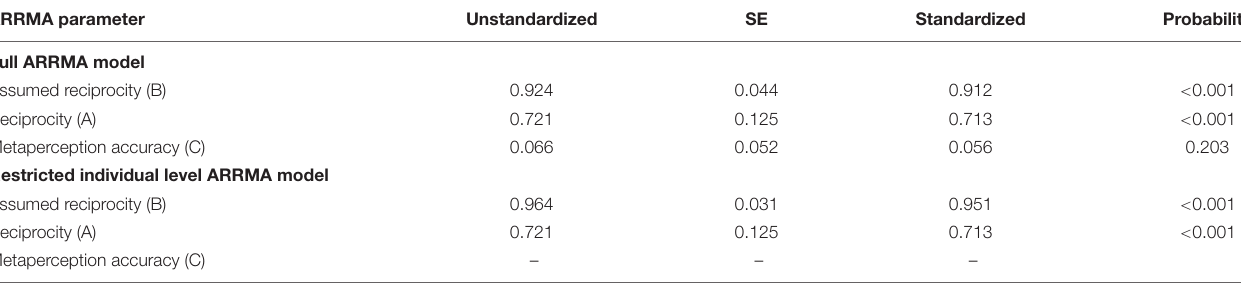
TABLE 2 | Individual level ARRMA model: perceived interpersonal similarity in